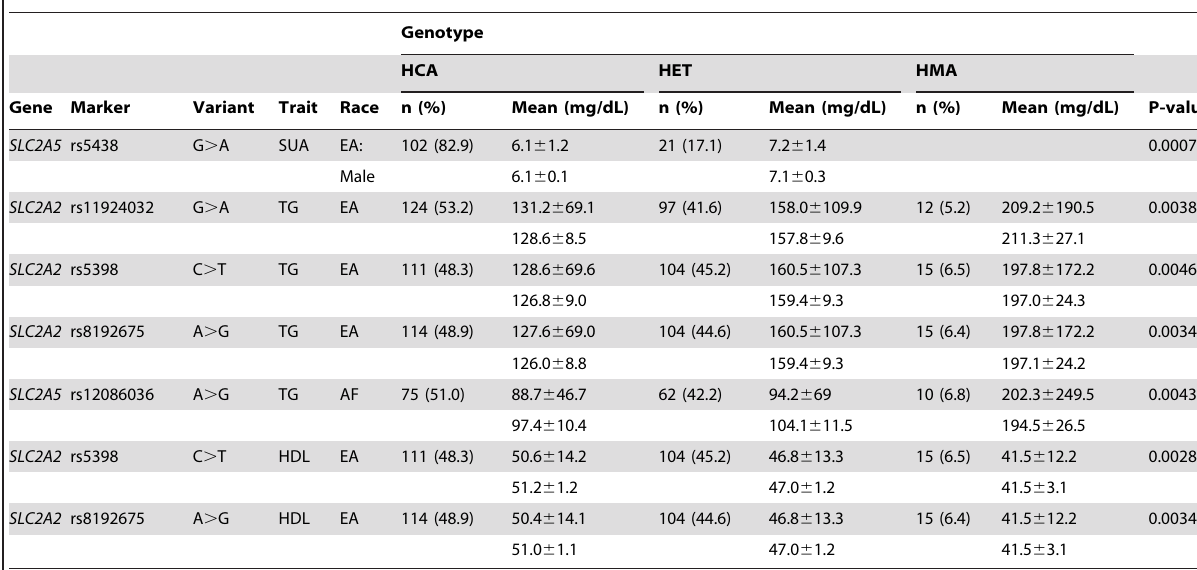
Table 2. SNPs significantly associated with baseline traits in PEAR.